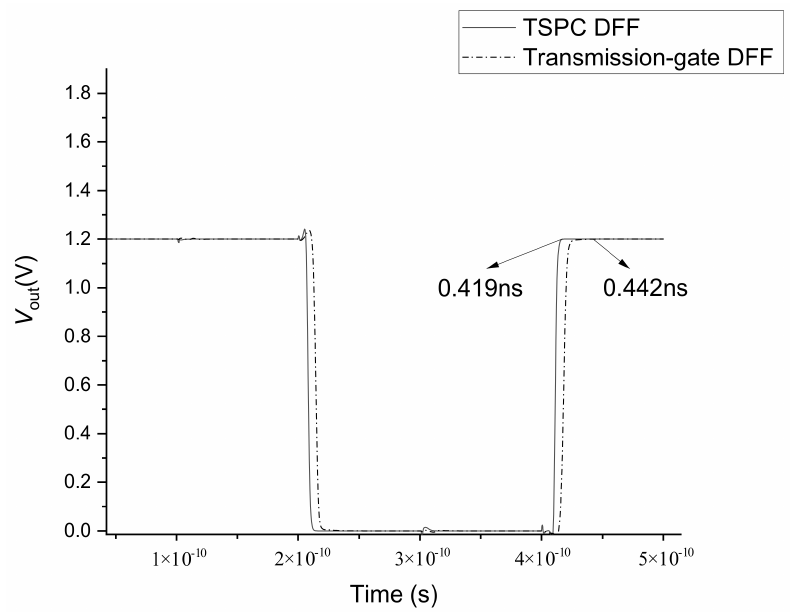
Figure 7. Simulated time delay of asynchronous divide-by-2 circuits based on different kinds of